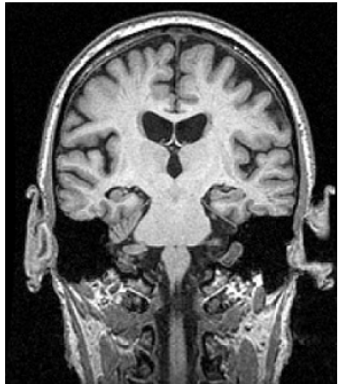
Figure 1. One Slice of T-1